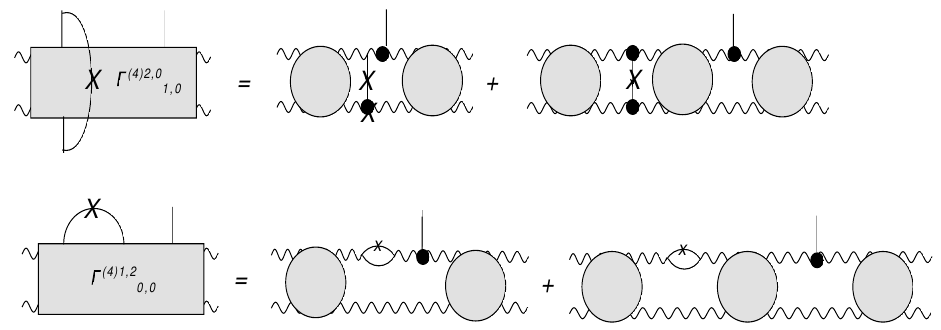
Figure 21 . Closing the 7-point